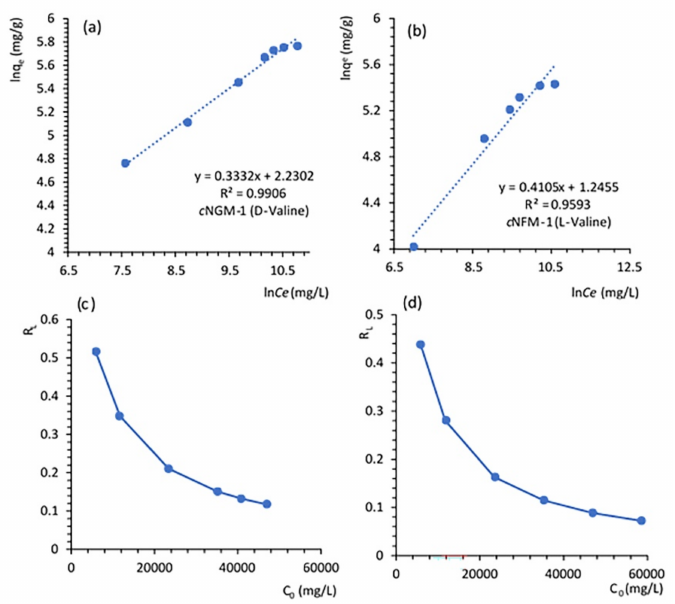
Figure 5. Freundlich isotherms curves and fitting data for adsorption of the favoured enantiomers of valine in ( a ) c NGM-1 and ( b ) c NFM-1 adsorbents at 25 ◦ C. The change in separation factor as a function of valine concentration is plotted in ( c ) for c NGM-1 and ( d ) for c NFM-1. Linear plots for the Freundlich isotherm (Figure 5) yield a lower correlation coefficient (R 2 ) value for both c NFM-1 ( L -valine) an c NGM-1 ( D -valine) with heterogeneity factors n F = 2.44 and n F = 2.96, respectively. Isotherms with n > 1 represent a high affinity between adsorbate and adsorbent [30,41]. Table 1 shows a comparison of the Langmuir and Freundlich relative parameters (K F , n F , and R 2